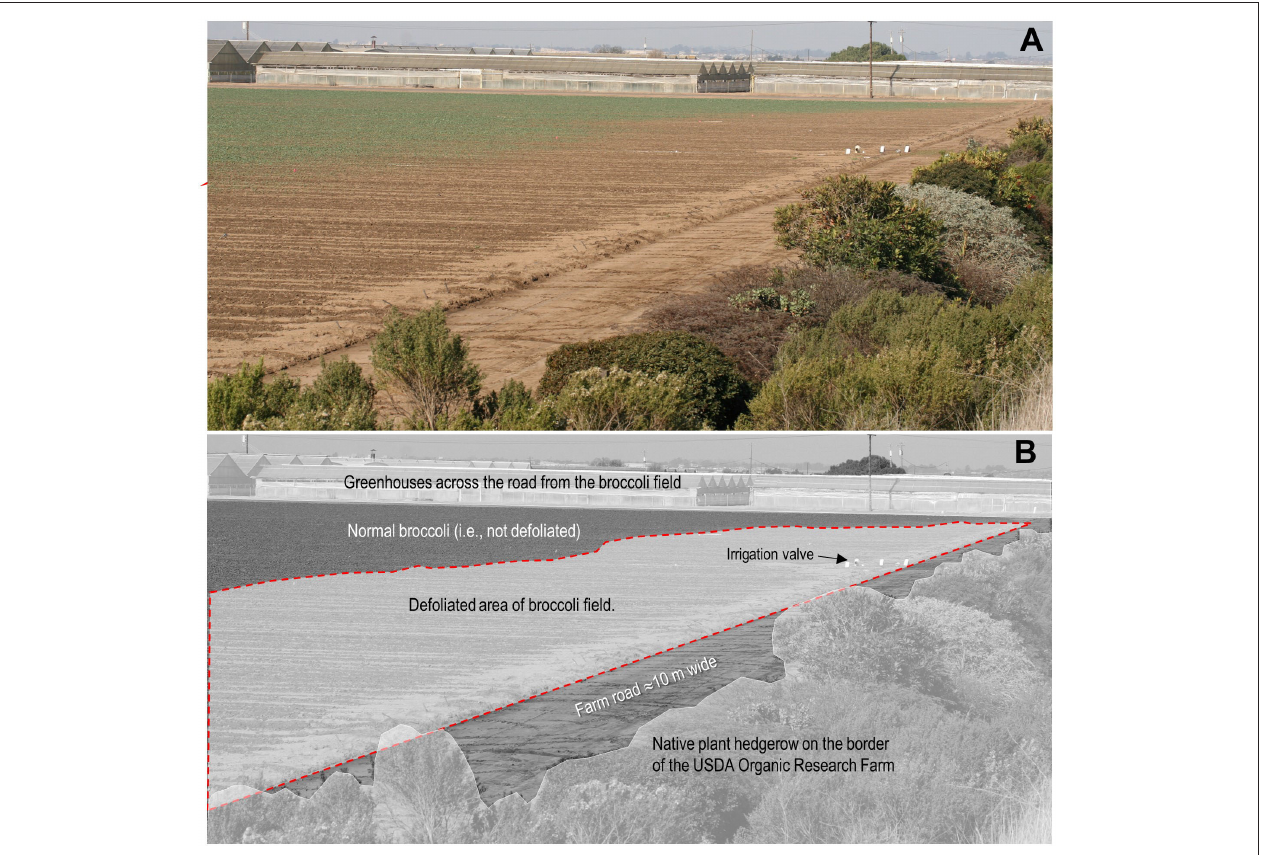
FIGURE 8 | Defoliated broccoli in a conventional farm adjacent to the hedgerow on the USDA organic research farm in Salinas, CA. The color photograph (A) was taken Jan 31, 2012 and shows the defoliated area from feeding by the White-crowned Sparrow, that extending ∼ 10m into the broccoli field or ∼ 20m from the edge of the hedgerow. Key features of the photograph are labeled in the black and white version (B) . The fields adjacent to the hedgerow on the organic farm had strawberries and a rye cover crop when the photograph was taken. See Figure 1B for an aerial view of this conventional broccoli field relative to the experimental field described in the paper. There is an asphalt road (Spence Road) between the broccoli field the greenhouses in the background. The geographic coordinates of the irrigation value in the field are 36 ◦ 37’18.4 “N 121 ◦ 32’59.1”